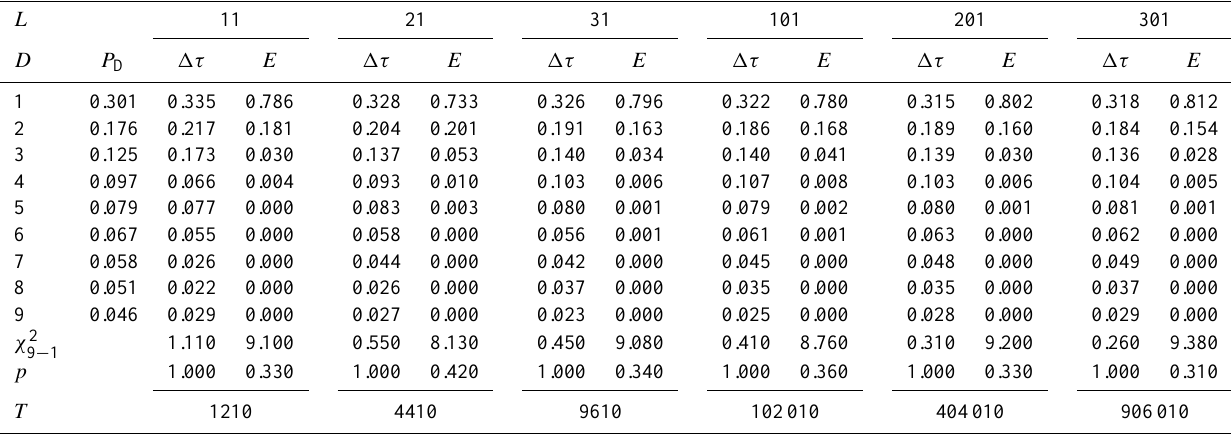
Table 2. Sand pile one-dimensional cellular automaton (Bak et al., 1988). First digit statistics for various one-dimensional cellular automata of different sizes.